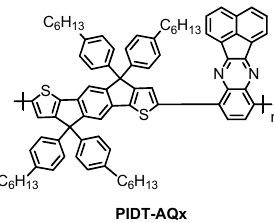
Figure 1. The chemical structure of PIDT-AQx in this work.